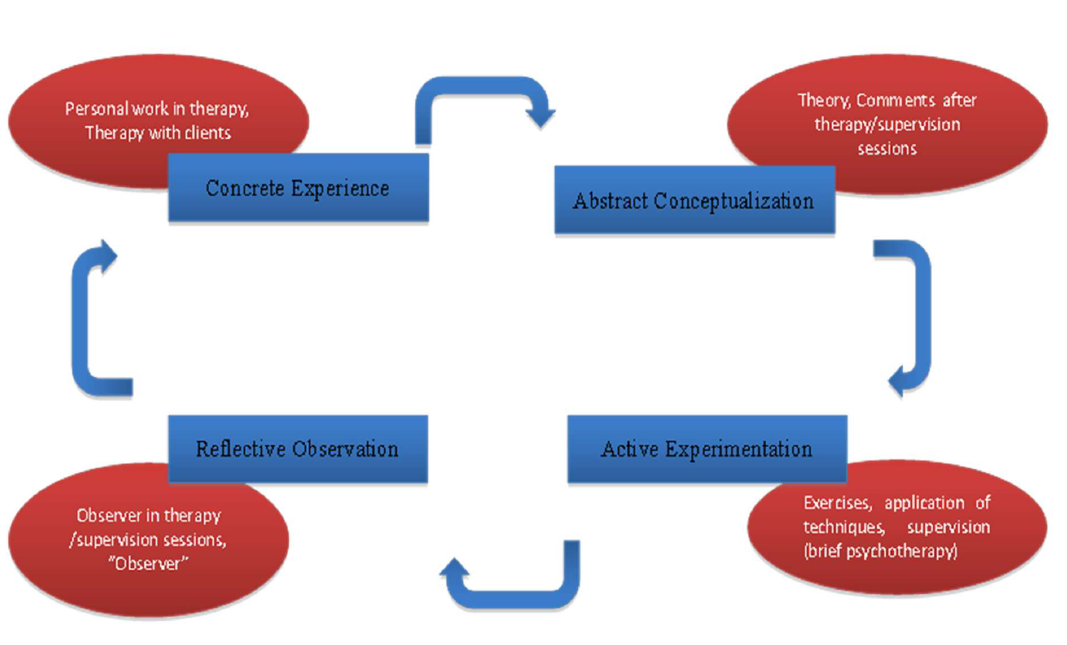
Figure 2: Examples of activities in our training program and related learning